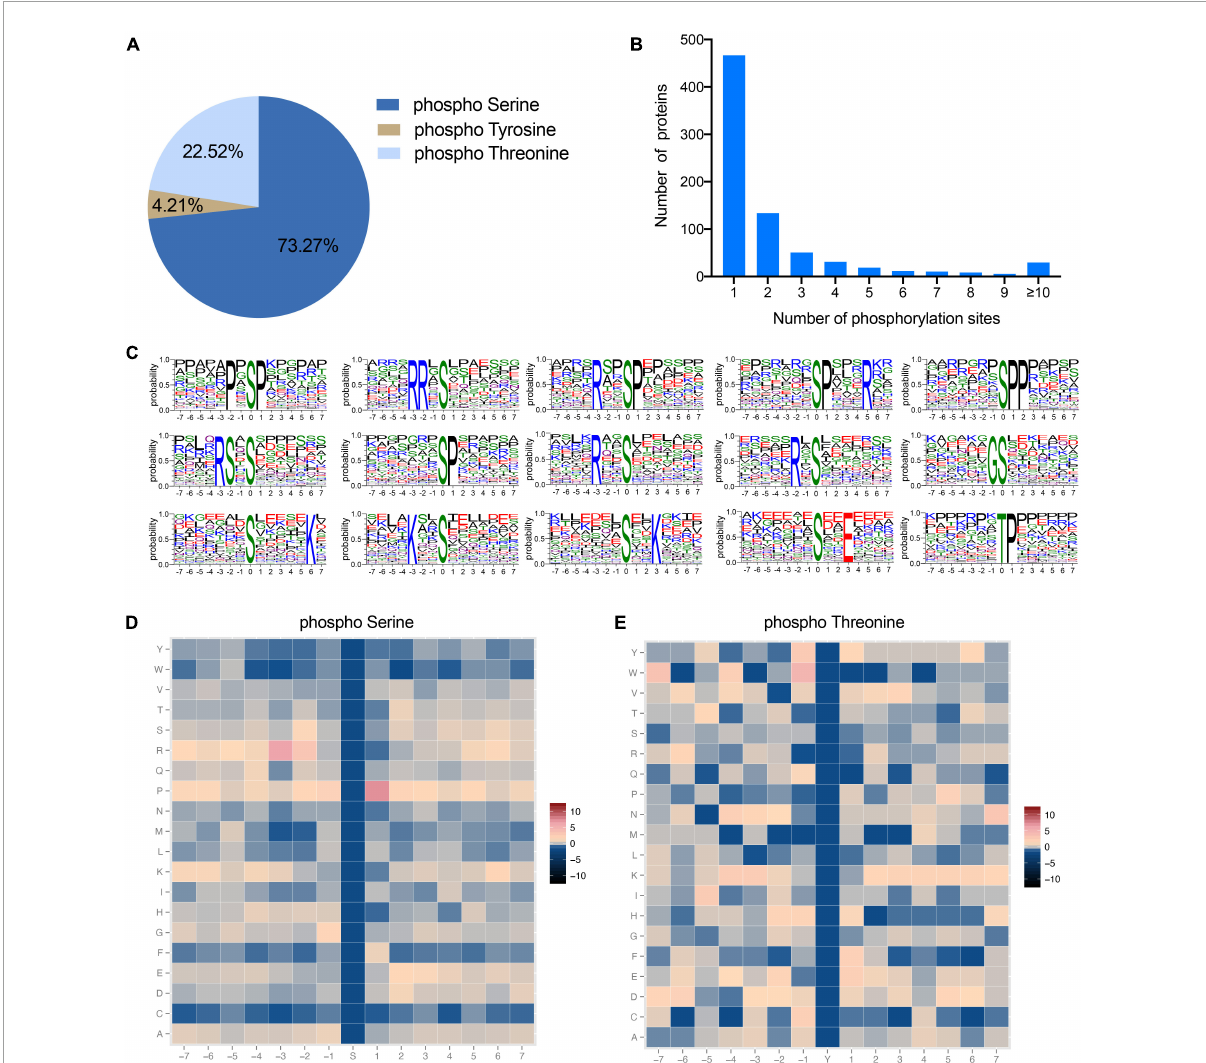
FIGURE2 Characterization of identified phosphorylation sites. (A) Distribution of amino acids in the identified phosphorylation sites. (B) Number of phosphorylation sites in each protein. (C) Enriched sequence motifs of phosphorylation sites together with the seven amino acid sites upstream and downstream of the phosphorylation site. The height of each letter represents the probability of finding that amino acids in the motif. The central amino acid represents the phosphorylation site. (D,E) Heatmaps of the frequencies of the different amino acids flanking the phosphorylated serine and threonine residues, respectively. Different colors represent the possibilities.